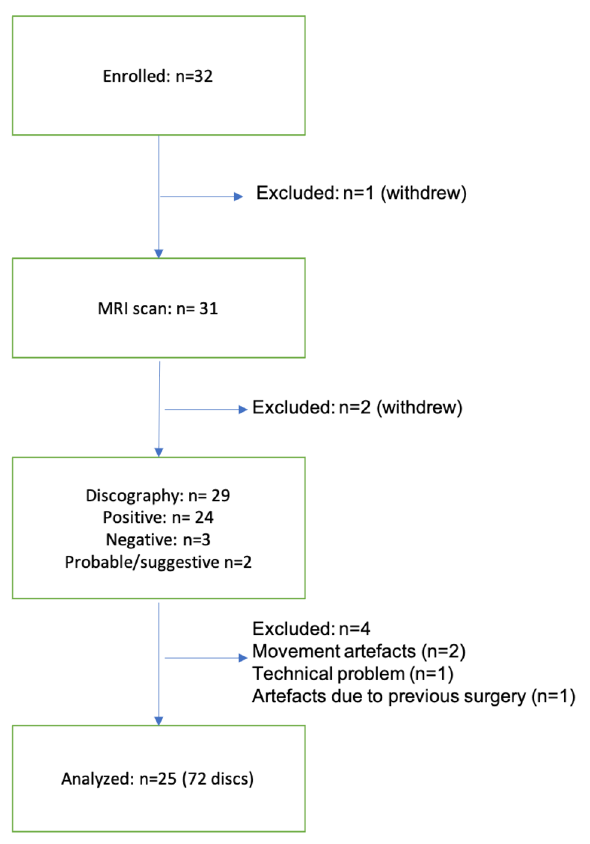
Figure 1. Flowchart of